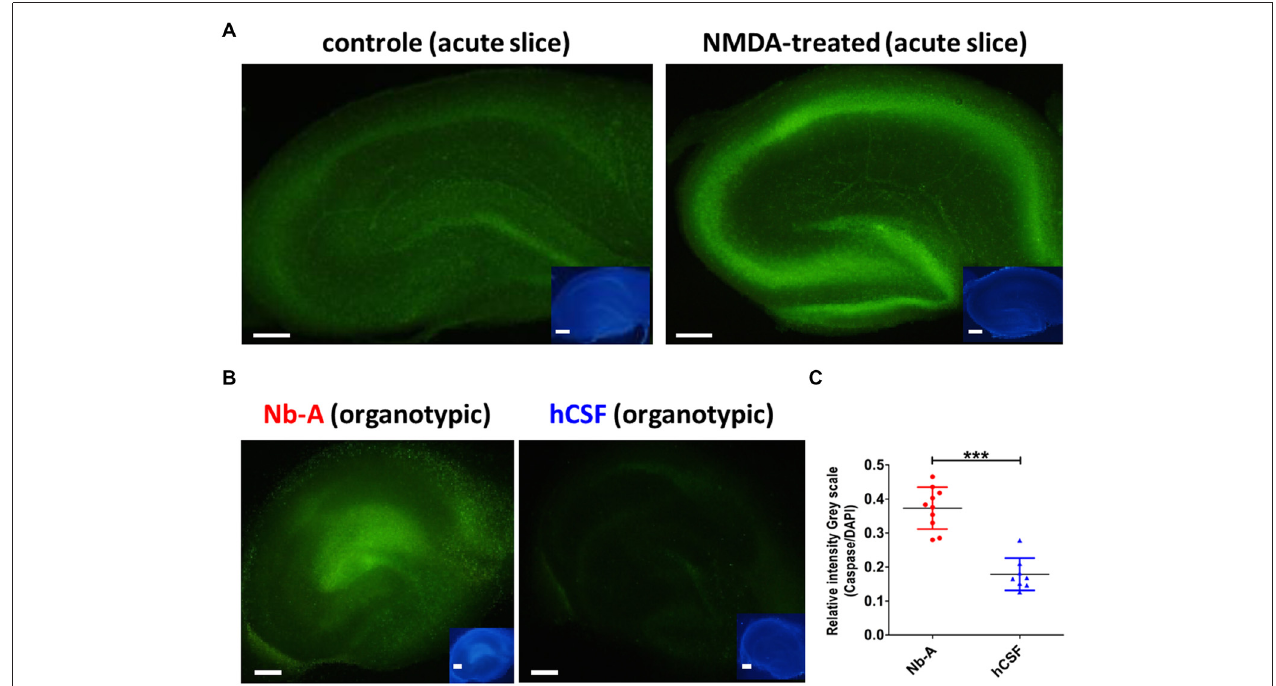
FIGURE 5 | Expression of the cell death marker caspase-3/7 in organotypic hippocampal slices cultured in Nb-A and in hCSF. (A) Validation of caspase-3/7 staining as reporter of NMDA-induced cell death in acute hippocampal slices. Examples showing caspase-3/7 staining of an acute hippocampal slice exposed to 150 µ M of NMDA for 1 h (left), and a control slice left untreated for 1 h (right). Inserts show the same slices stained with DAPI. (B) Examples showing caspase-3/7 staining of an organotypic hippocampal slice cultured in Nb-A for 9 days (left), and in hCSF for 9 days (right). Insets show the same slices stained with DAPI. (C) Diagram showing average intensity of caspase-3/7 staining (the ratio of Caspase-3/7 intensity to DAPI intensity, in gray scale) in organotypic hippocampal slices cultured in Nb-A (red, N = 10, 0.37 ± 0.06) and in hCSF (blue, N = 8, 0.17 ± 0.04). Intensities were measured in the CA1 area at three independent locations per preparation and averaged (mean ± SD). ∗∗∗ p <